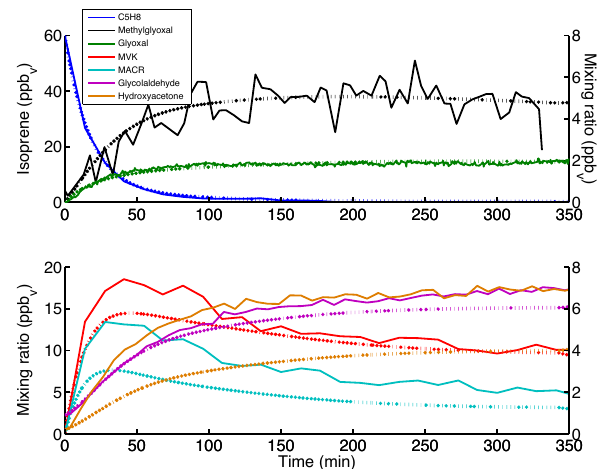
Fig. 3. Model and measurement comparison for high-NO x isoprene oxidation (Exp.7) using the modified MCM model. The glycolalde- hyde to glyoxal yield was set to 29%, and first generation yields of glyoxal (2.6%), methylglyoxal (2.7%), hydroxyacetone (2.6%), and glycolaldehyde (2.7%) were included in this model run. Gly- oxal production from C5 hydroxycarbonyls was attenuated to 1/6 of the MCM v.3.2